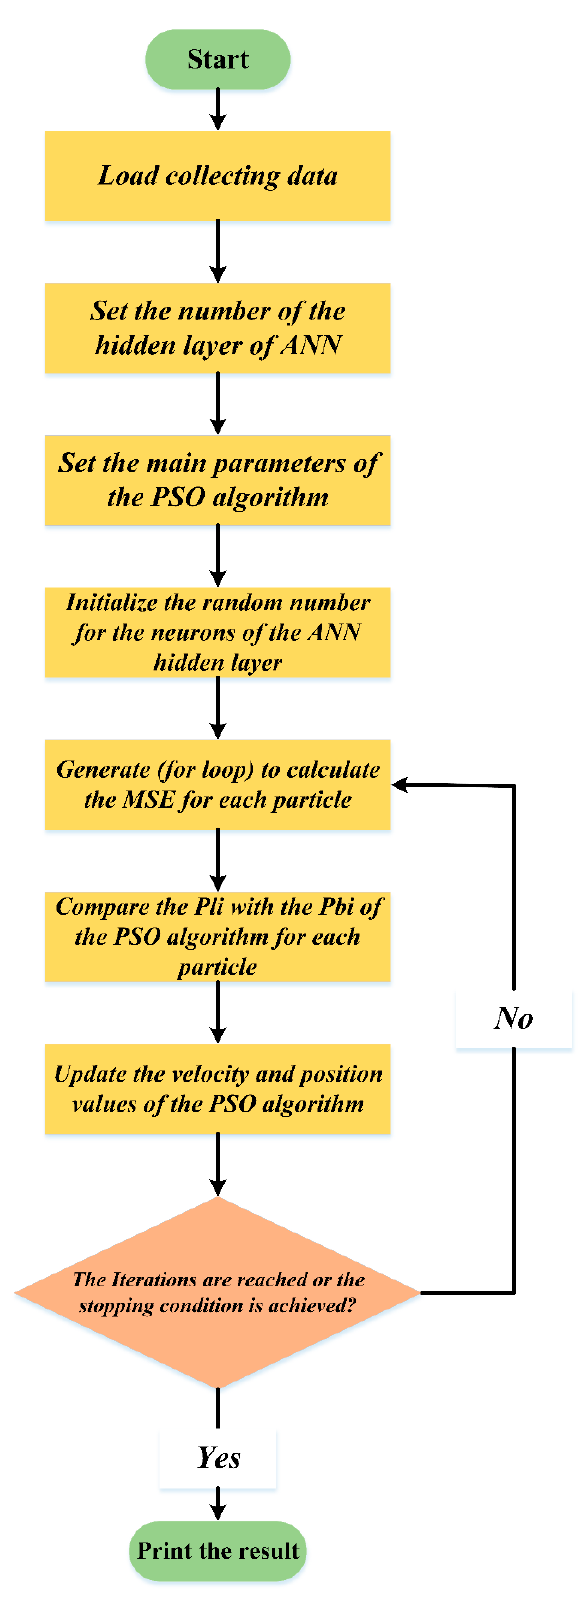
Figure 10. The first proposed algorithm to determine the optimised topology of the ANN.